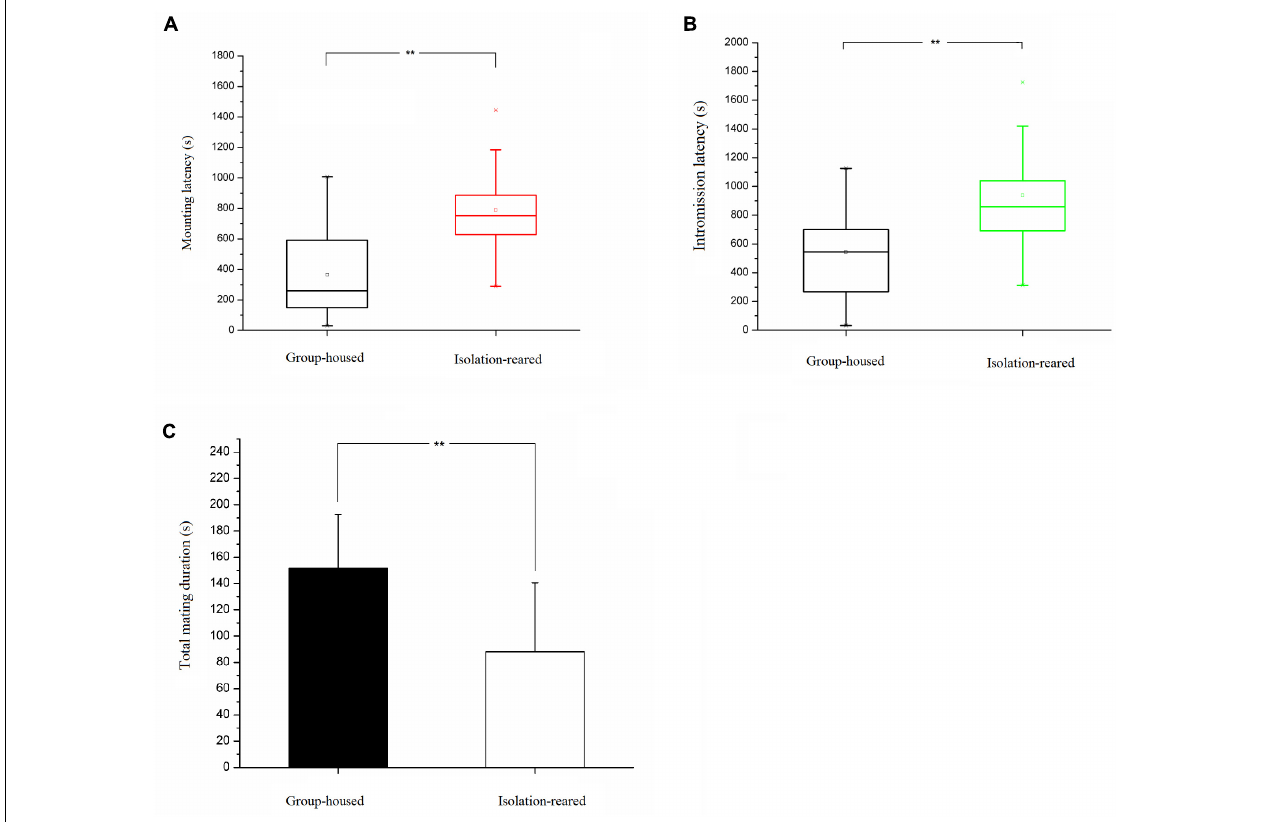
FIGURE 6 | Results of heterosexual behavior test. (A) Box plot of the mounting latency of isolation-reared and group-housed mice. (B) Box plot of the intromission latency of isolation-reared and group-housed mice. (C) The total mating duration of isolation-reared and group-housed mice. ∗∗ Indicate p < 0.01.